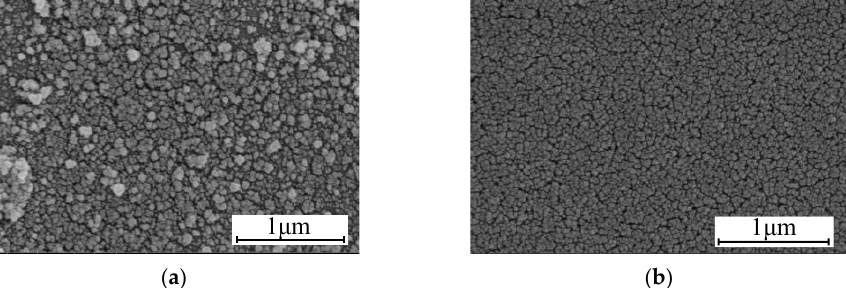
Figure 3. The surface morphologies by SEM of unmodified (M/T = 0.3) film ( a ) and the film after treatment ( b ).